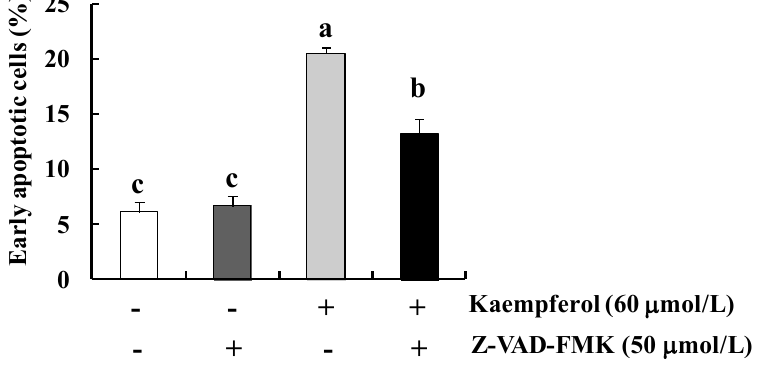
Figure 6. The caspase inhibitor Z-VAD-FMK attenuates kaempferol-induced apoptosis in HT-29 cells. Cells were plated in 24-well plates and treated with 50 μmol/L Z-VAD-FMK for 1 h. Cells were then treated with 0 or 60 μmol/L kaempferol with or without 50 μmol/L Z-VAD-FMK for 48 h. Cells were trypsinized, loaded with Annexin V and 7-AAD, and analyzed by flow cytometry. The percentages of early apoptotic cells were calculated. Each bar represents the mean ± SEM ( n = 3). Means without the same letter (a, b or c) are significantly different ( p <